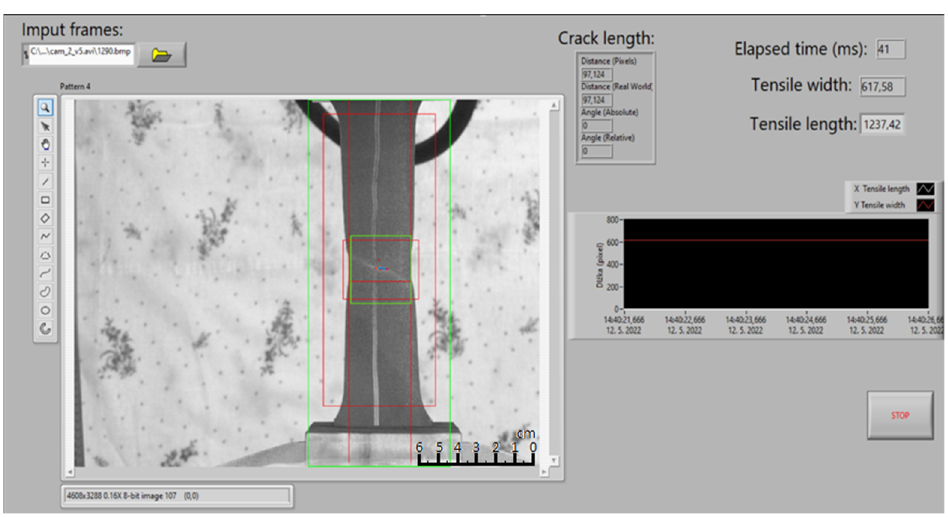
Figure 9. Front panel of the application in LabVIEW environment. The basic settings for pattern search and pattern parameter determination are located on the left side of the panel. The output image from the camera, as well as the detection